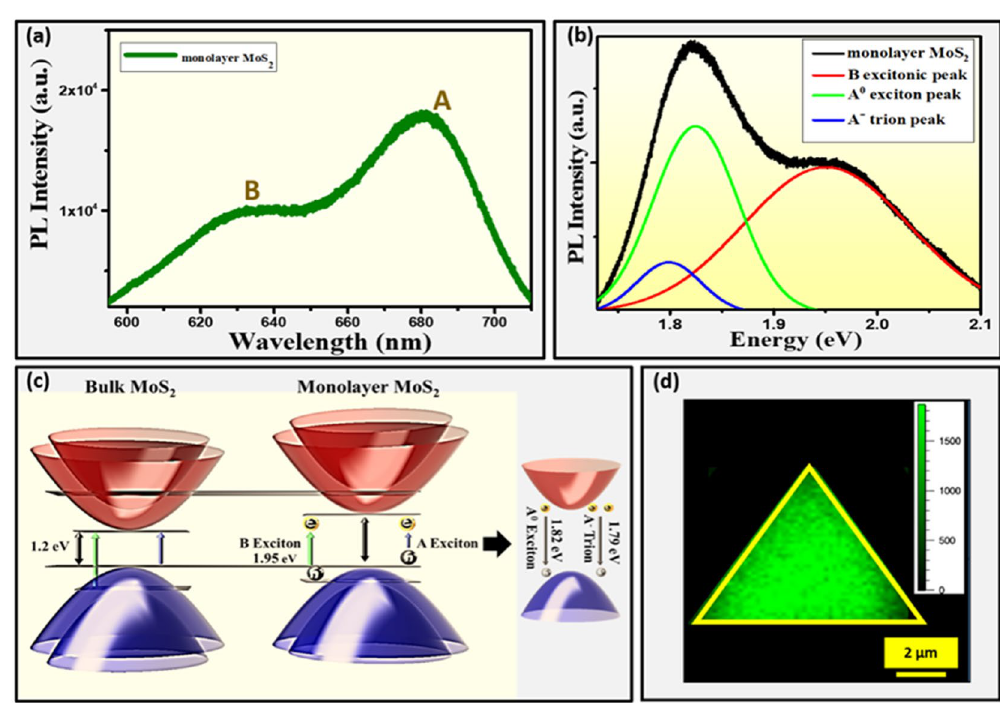
Figure 4. PL Characterization and Mechanism. ( a ) PL spectrum of monolayer MoS 2 over 300 nm thick